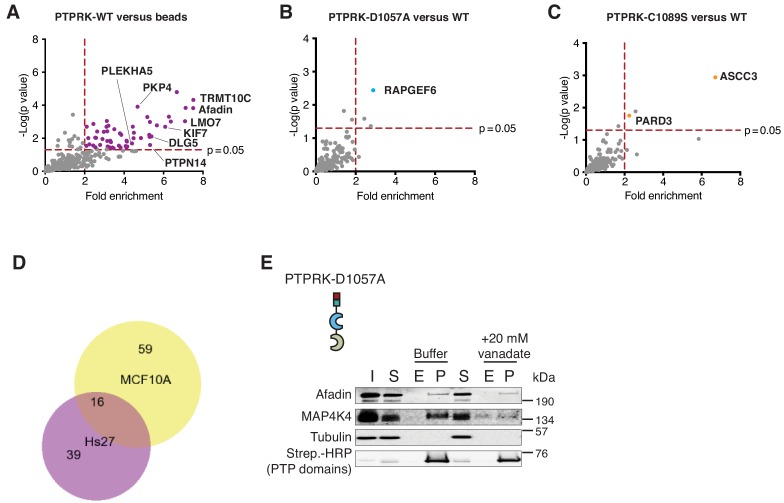
PTPRK interactome from Hs27 cell lysates and vanadate competition.(A–C) Volcano plots showing statistically enriched (p<0.05, n = 3) proteins bound to the indicated recombinant proteins after pull downs from pervanadate-treated confluent Hs27 cell lysates comparing PTPRK-ICD to beads control (A), PTPRK-ICD-D1057A to PTPRK-ICD (B) and PTPRK-ICD-C1089S to PTPRK-ICD (C). Grey points that appear significant were consistently found on the beads-only control. (D) Comparison of proteins enriched on the PTPRK-ICD after pulldowns from MCF10A and Hs27 lysates. Protein lists were used as inputs for BioVenn (Hulsen et al., 2008). (E) Pull downs using PTPRK-ICD D1057A and PTPRK-D2 domains from confluent, pervanadate-treated MCF10A lysates were incubated with and without 20 mM vanadate for 30 min. 4% inputs (I), 4% supernatants (S), 4% eluates (E; following treatment) and pull downs (P) were subjected to immunoblot analysis.